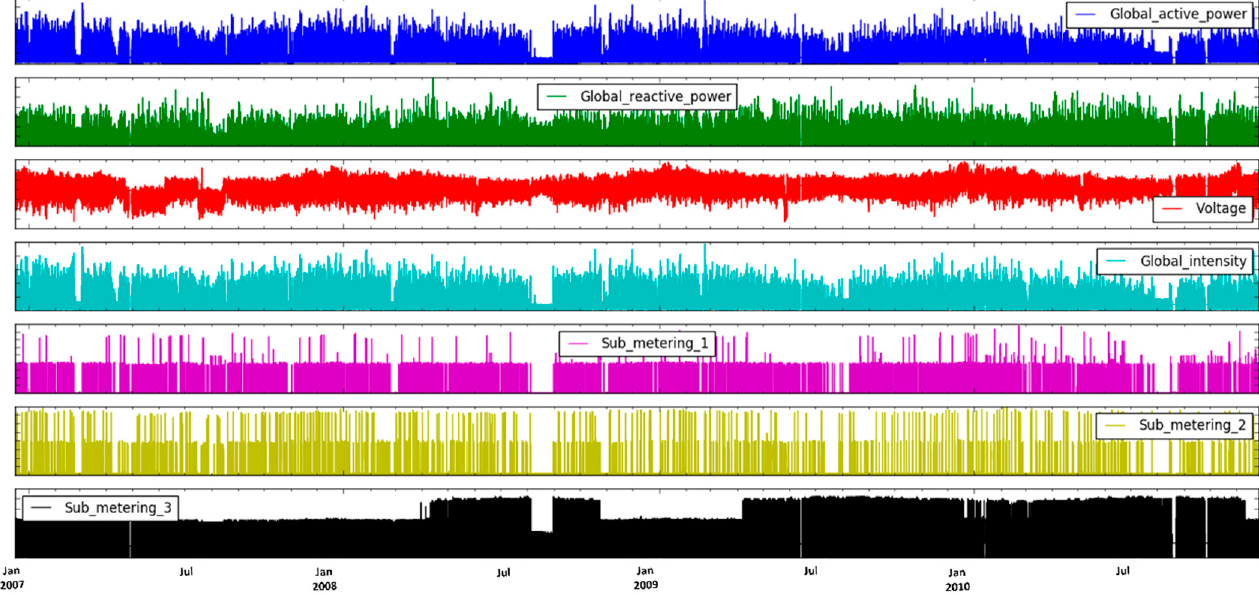
Figure 5. Detailed analysis using histogram where the Global Active Power (GAP) distribution is skewed towards low values.